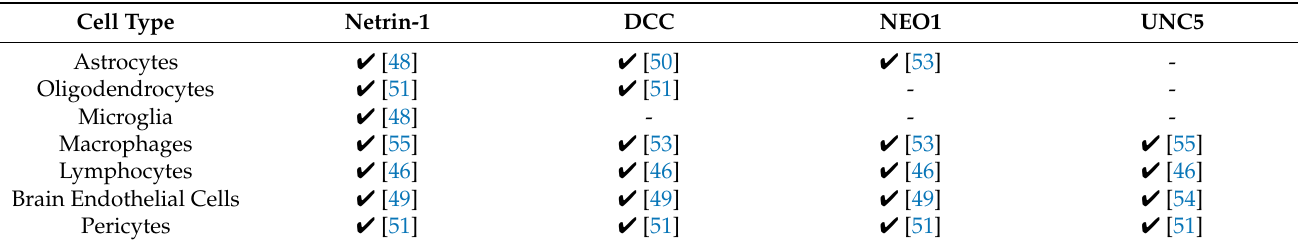
Table 2. Netrin-1 and its receptors expression in different cell types of the GBM